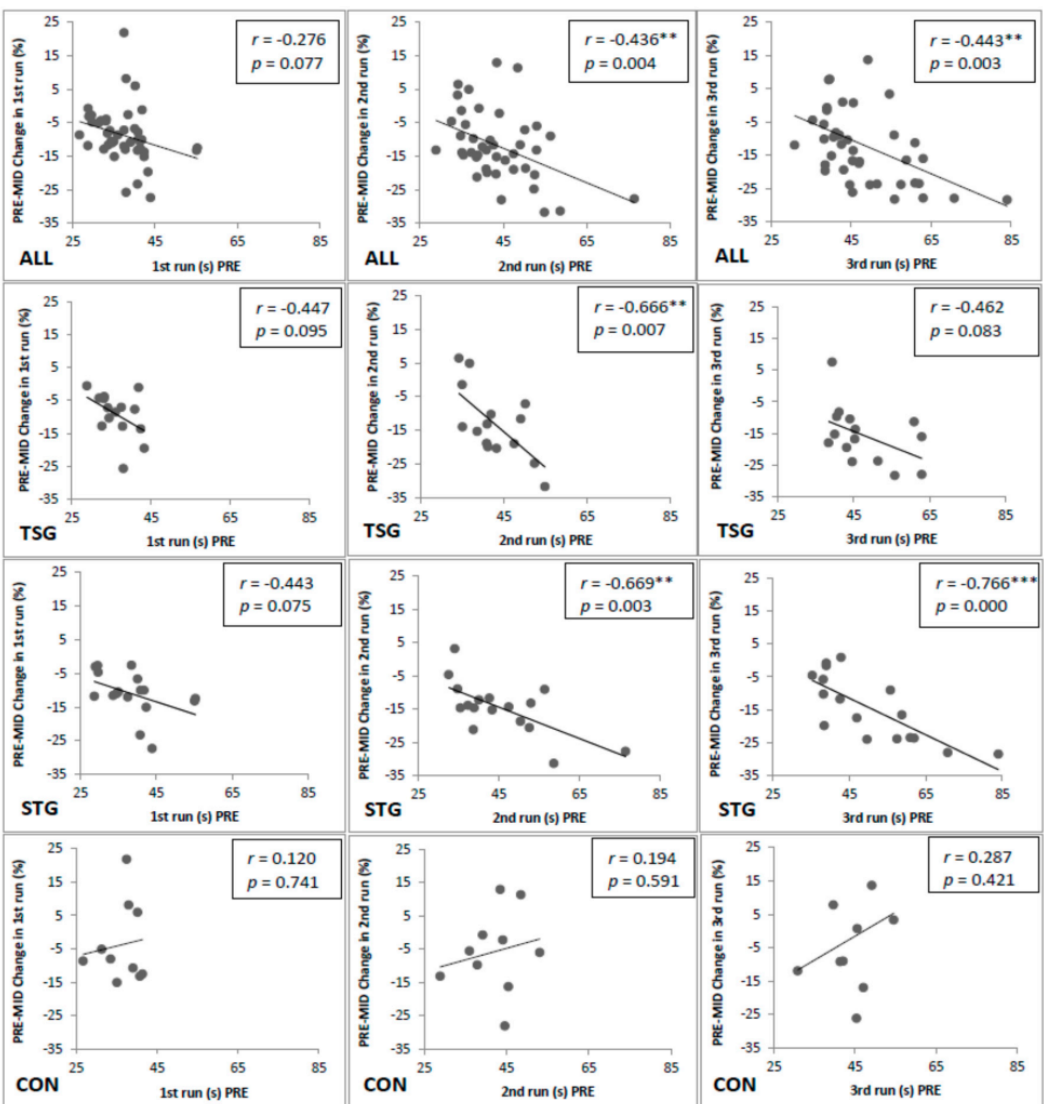
Figure 4. Correlations between absolute time in the 1st, 2nd, and 3rd run and the PRE–MID change (%) in time. ALL = all subjects; STG = strength training group; TSG = soldier task specific group; CON = control group; * = p < 0.05, ** = p < 0.01, *** = p <